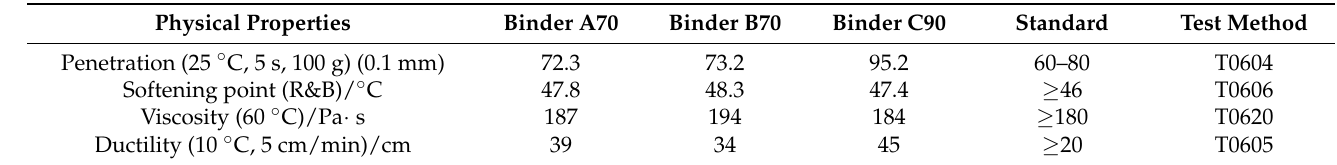
Table 1. Performance results of base